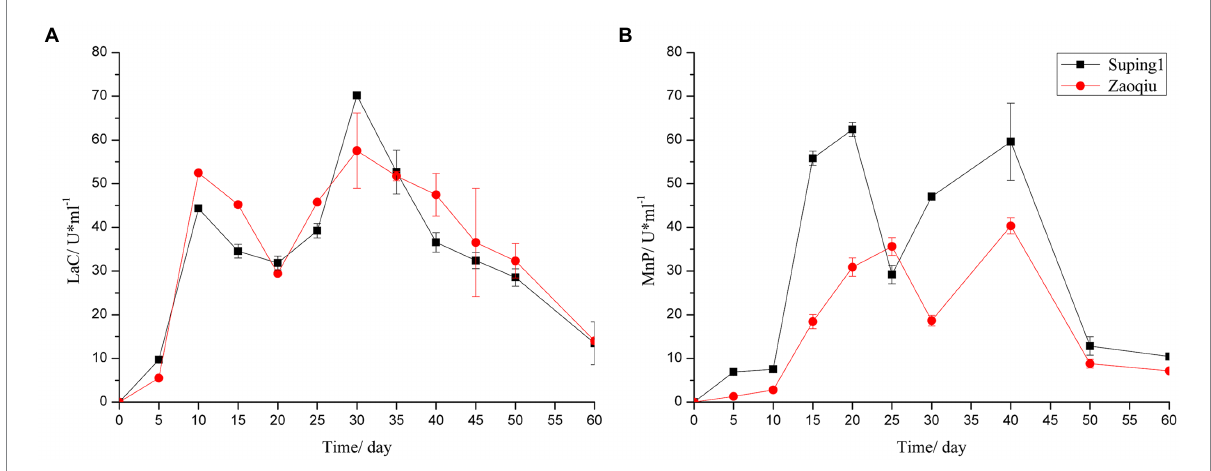
FIGURE 3 Ligninase enzyme activities of the cotton stalks degraded by P. ostreatus in solid-state fermentation. (A) Laccase; (B) Manganese peroxidase.